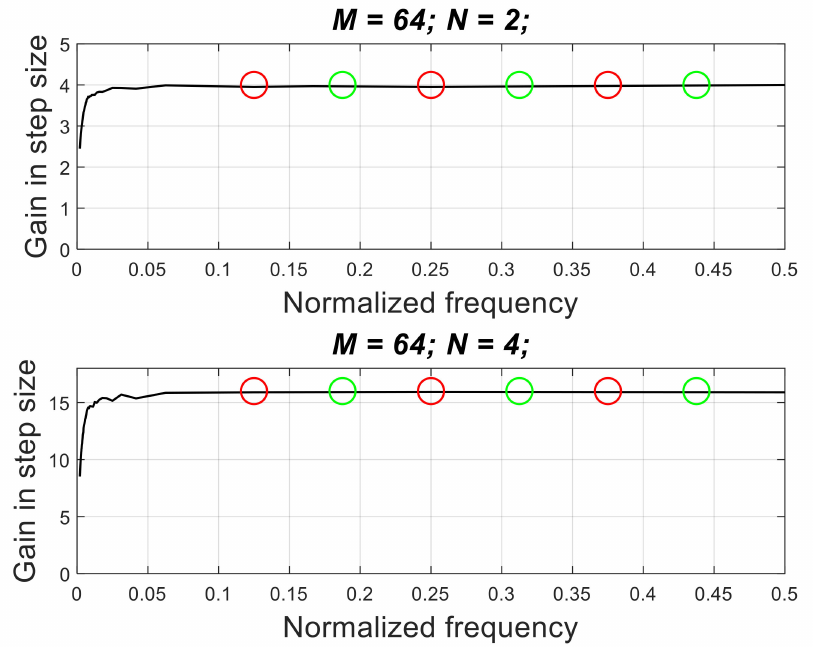
Figure 8. Gain in step-size for a single tone when using sequential PU with periodic LMS algorithm (matrix-based). The filter length is set to 64 taps. The decimation factor takes values 2 and 4. Apart from the very low frequency range, the step-size gain can be approximated by N 2 . Circles mark frequencies where reference and desired signals have significant harmonics; red circles mark components of x 1 ( n ) and green circles mark components of x 2 ( n ) .